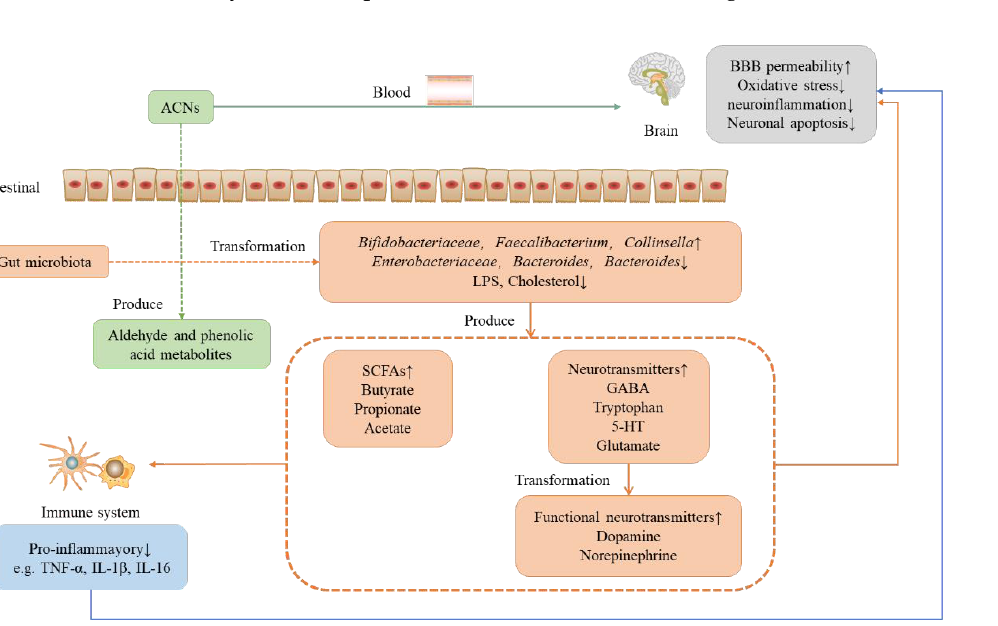
Figure 3. Role of anthocyanins on the nervous system under the microbial – intestinal – brain axis system. ACNS: anthocyanins; LPS: lipopolysaccharide; GABA; gamma aminobutyric acid; 5-HT: serotonin; SCFAs: short-chain fatty acids.